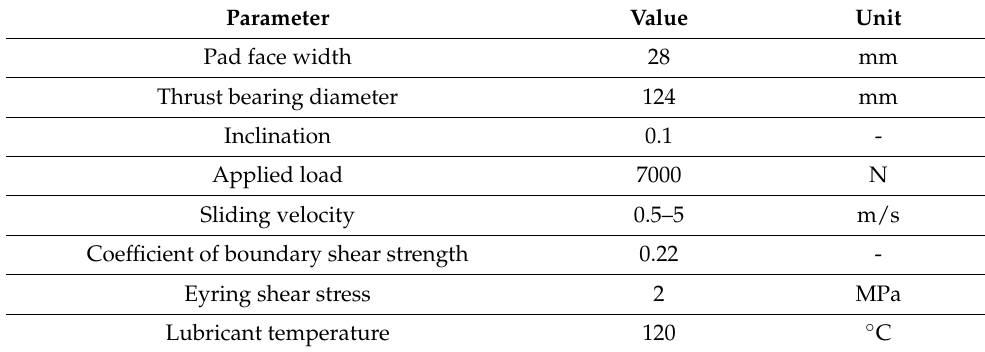
Table 3. Pivoted pad thrust bearing dimensions and operating conditions.